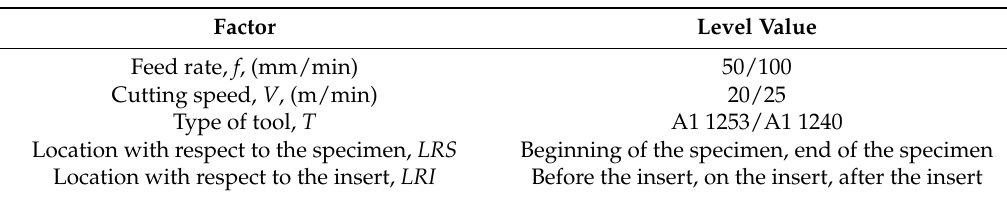
Table 4. Factor and level values.